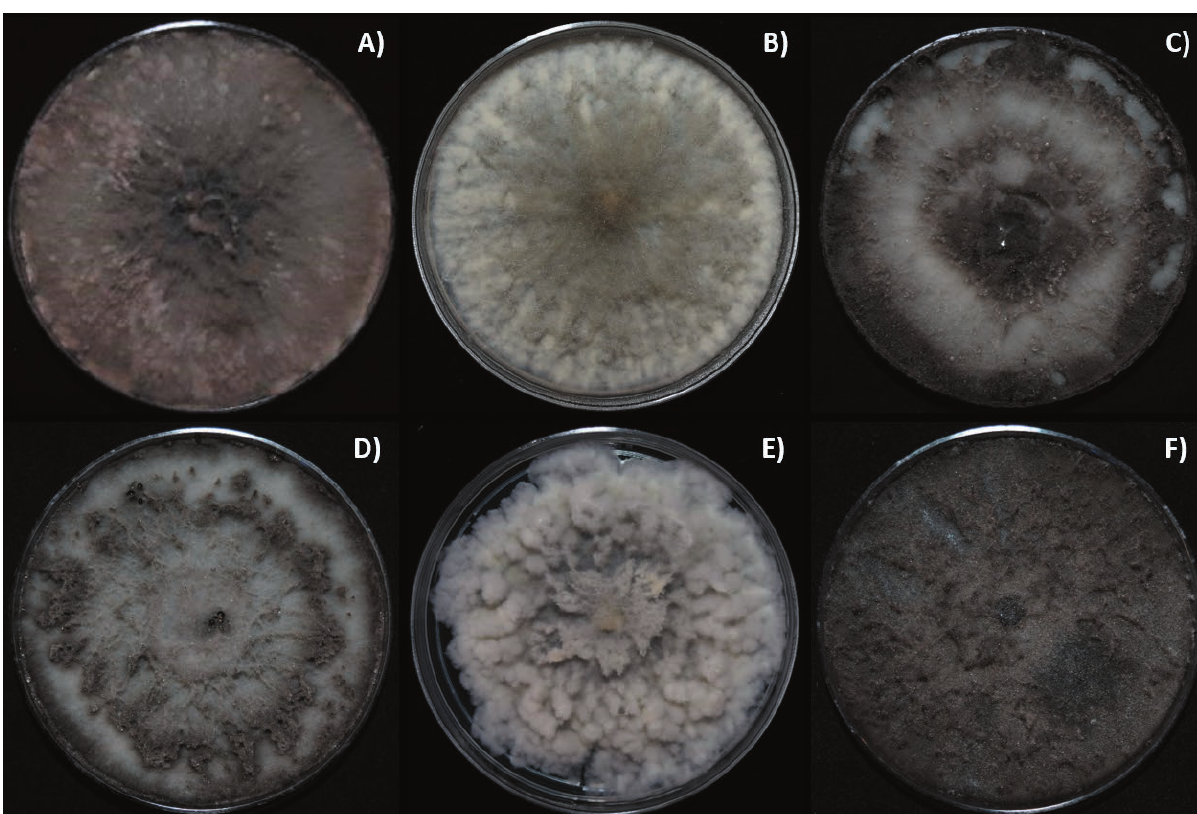
Figure 2. Lasiodiplodia spp. isolates grown on PDA at 30°C for 7 d. A) L. brasiliensis MXBCL28, B) L. brasiliensis MXVS18, C) L. exigua MXVS21b, D) L. exigua MXVS5a, E) L. gilanensis MXBCCS01, F) L. crassispora